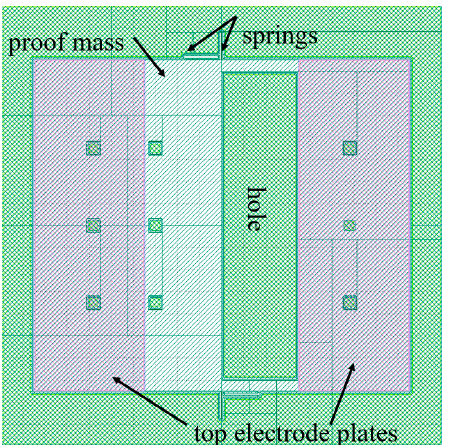
Figure 7. Layout of a torsional Z-axis accelerometer [31].